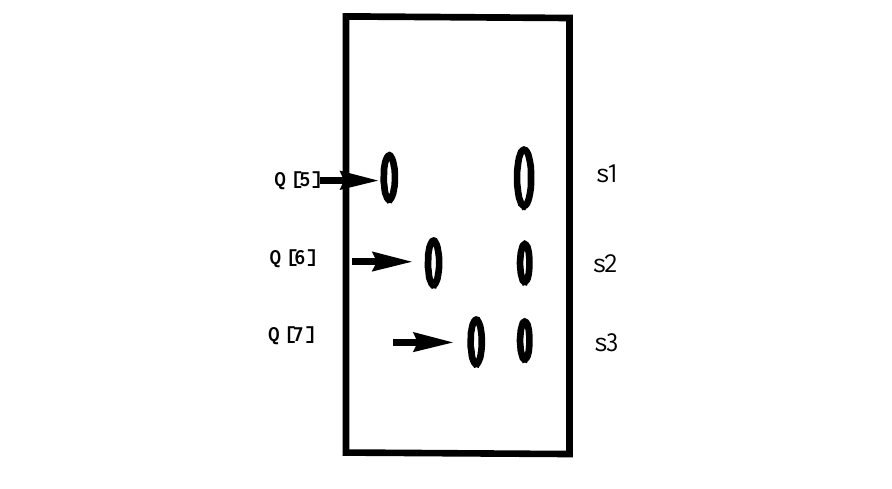
Figure 1. The TLC profile of the mixture of the substituted Qs (I